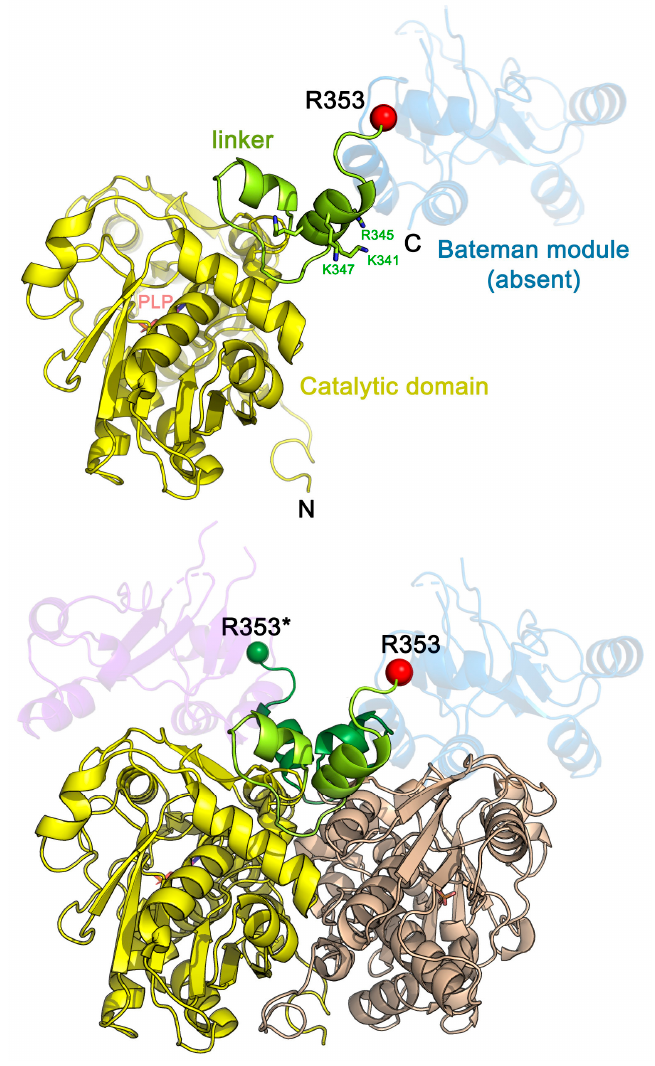
Figure 2. Structure of TgCBS R353*. Three-dimensional structure of the monomeric ( up ) and dimeric ( down ) construct R353* extrapolated from the crystal structure of TgCBS [22]. PLP and potential target residues of trypsin-cleavage are in sticks. The location of residue R353 in each monomer is indicated in red and green spheres. In the dimer, the catalytic domains of the complementary subunits are colored yellow and light brown, respectively. The Bateman modules (absent in the R353* construct) are represented in transparent ribbons (colored in blue and wine).